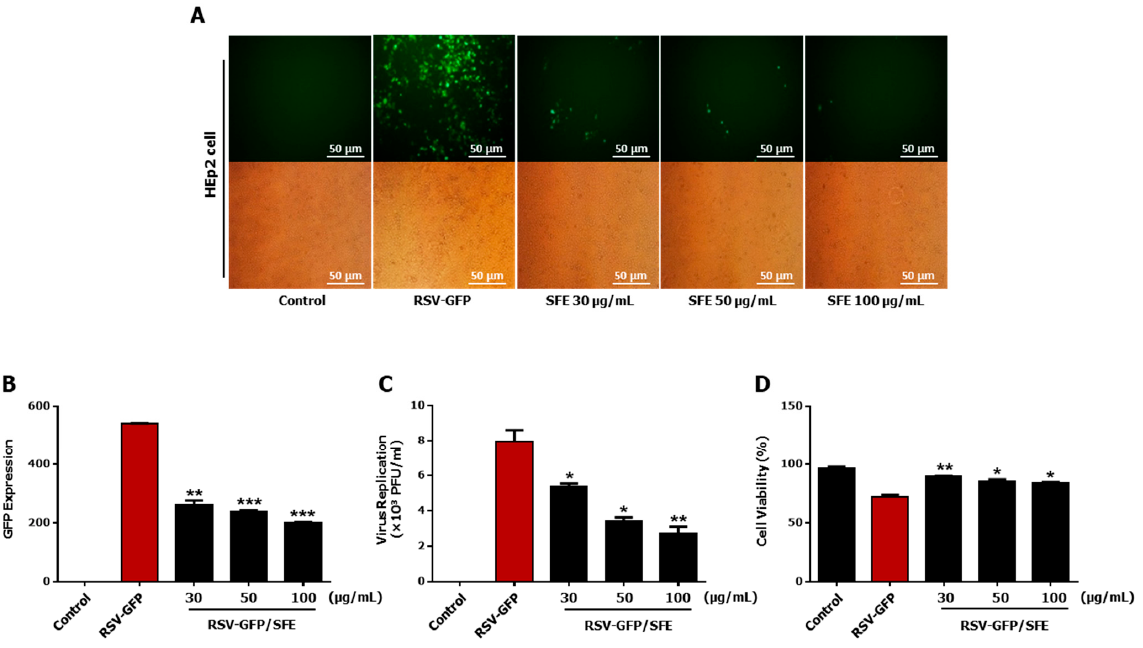
Figure 1. Antiviral activity of Sargassum fusiforme extract (SFE) in HEp2 cells. HEp2 cells were seeded into 12-well cell culture plates with the cell number of 1.5 × 10 5 cells/well. After 12 h, the medium was changed to 1% fetal bovine serum (FBS) containing Dulbecco’s modified Eagle medium (DMEM), and cells were infected with Green Florescence protein tagged Respiratory Syncytial Virus (RSV–GFP) 0.1 Multiplicity of Infection(0.1 MOI) or kept uninfected. After 2 h, the medium was replaced with 10% FBS containing DMEM, and cells were treated with 30, 50, 100 ( µ g/mL) Sargassum fusiforme extract (SFE). Cells without any treatment regard as virus only. ( A ) After 48 h, images were obtained (200 × magnification). ( B ) Green Fluorescence protein (GFP) absorbance levels were measured by Glomax multi-detection luminometer (Promega). ( C ) Viruses were titrated from the cell supernatant and cells by standard plaque assay. ( D ) Cell viability was determined by trypan blue exclusion assay at 48 hpi. Scale bar-50 µ M. GFP absorbance, cell viability, and virus titer expressed as mean ± SD. Error bars indicate the range of values obtained from counting duplicates in three independent experiments (* p < 0.05, ** p < 0.01, and *** p < 0.001 regarded as significant difference).